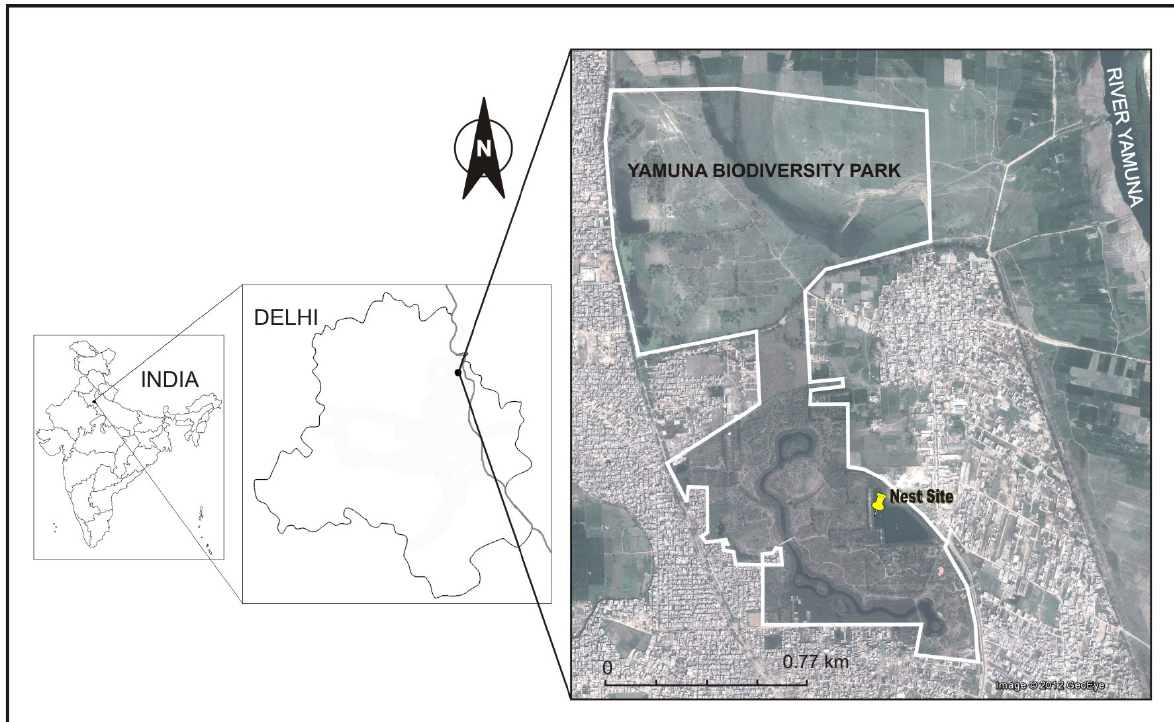
Figure 1. Map of Yamuna Biodiversity Park showing the nesting site. The insets show the locations of YBP in Delhi and Delhi in